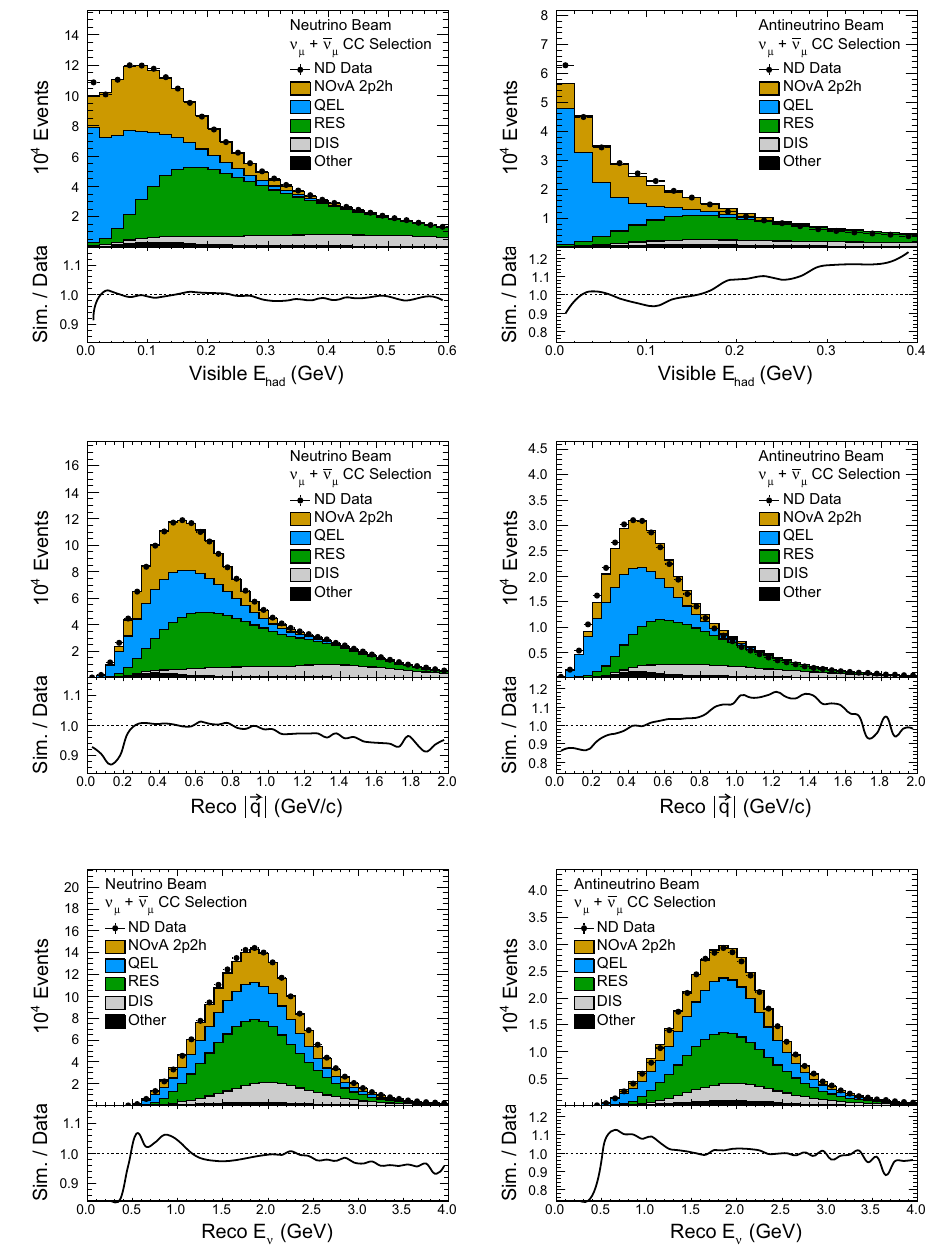
Fig. 7 Comparison of adjusted simulation to data in the 2p2h tuning variables E vis (top row) had and reconstructed |(cid:2) q | (middle row), as well as reconstructed E ν (bottom row), for neutrino beam (left) and antineutrino beam (right). The simulation is broken up by interaction type, shown as stacked histograms 0.0